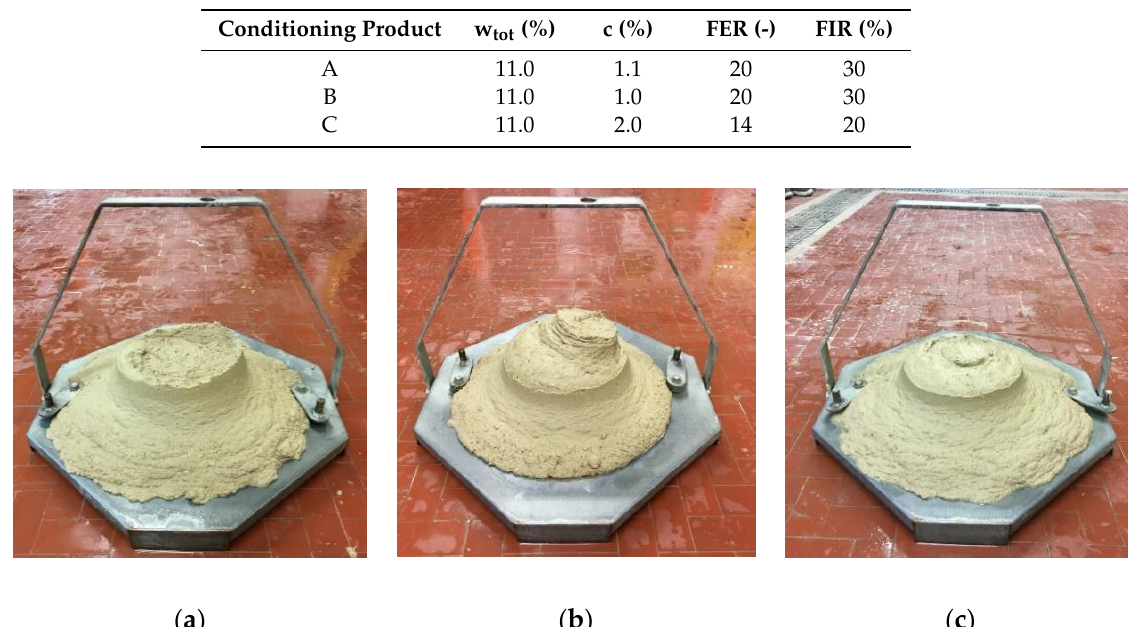
Table 1. Conditioning set parameters for the three studied conditioning agents.